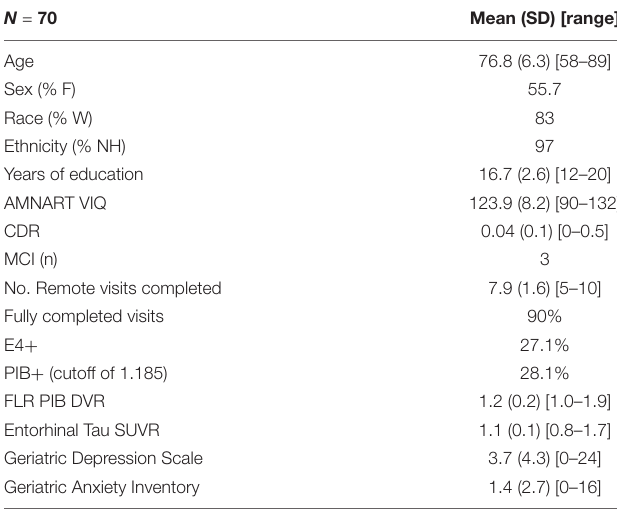
TABLE 1 | Participant demographics at